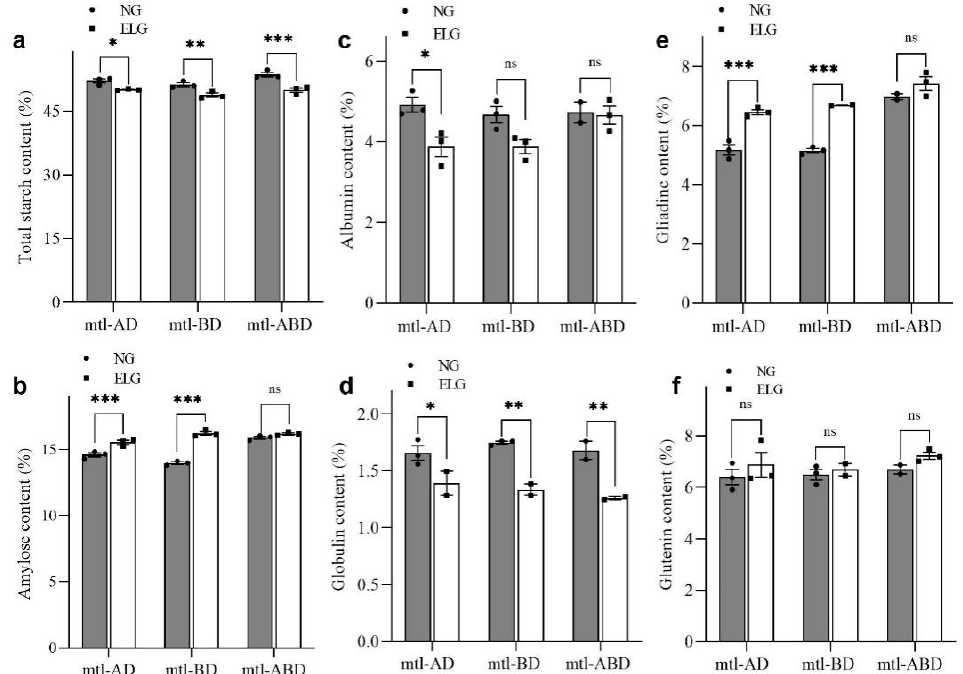
Figure 6. Nutrient accumulation in embryoless wheat grains of the mtl mutants. ( a – f ) Contents of starch, amylose, albumin, globulin, gliadin, and glutenin in the mtl grains. *, **, *** and ns indicated significance at p < 0.05, p < 0.01, p < 0.001 and no significance in order.